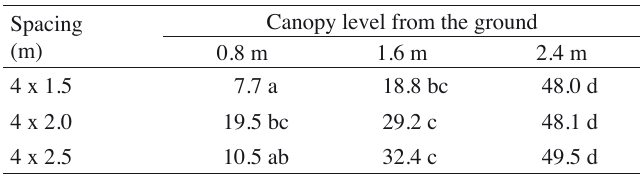
Table 7 - Influence of spacing on % light distribution in three canopy levels of ‘Silvia’ cultivar in the fifth year from planting